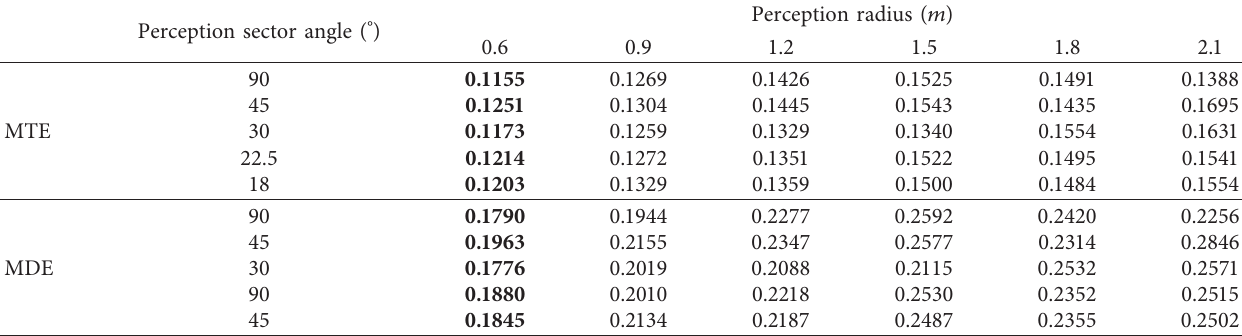
Table 3: MTE and MDE of simulation cases with different perception radius and sector angles for the unidirectional flow scenario. Perception sector angle ( ° )